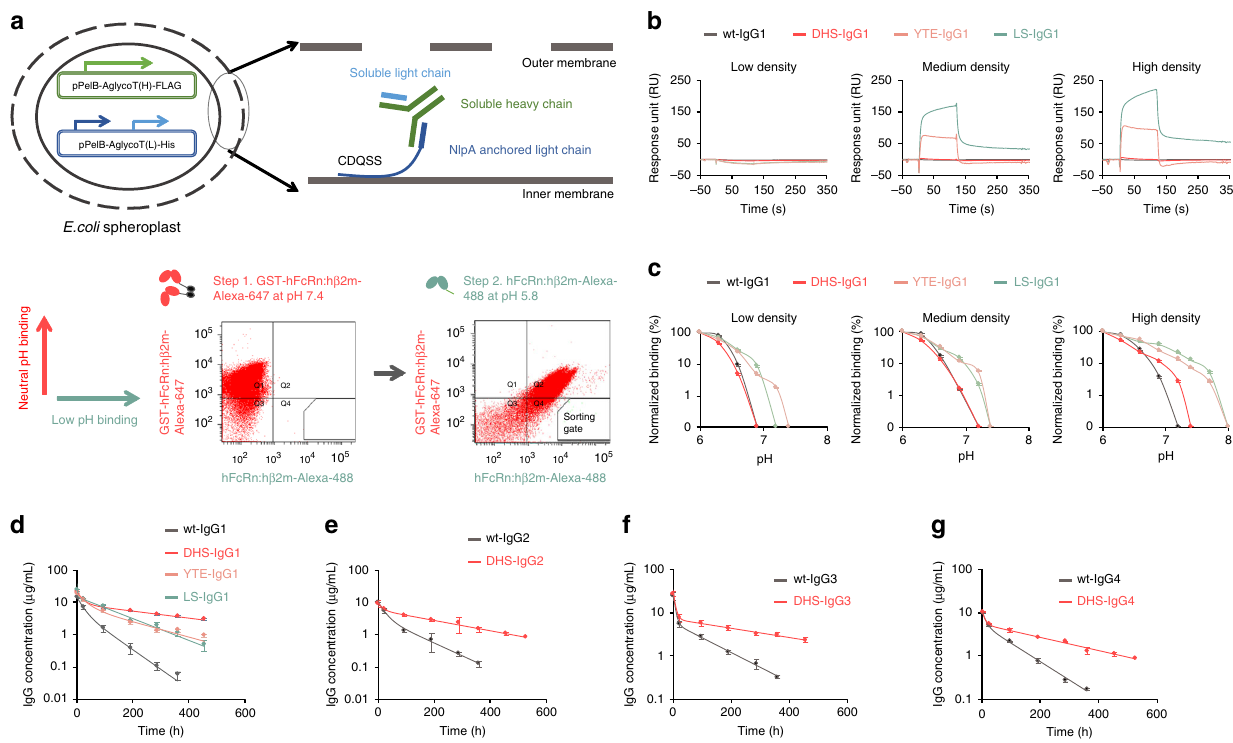
Fig. 1 Engineering a human Fc domain with optimized pH-dependent FcRn binding for ultra-long circulation persistence. a Screening strategy for the isolation of Fc mutations that confer favorable pH-dependent FcRn-binding using E. coli display. b , c SPR binding of IgG mutants (800 nM) to hFcRn:h β 2m immobilized at low, medium, or high density (500, 2000, and 4000 RU, respectively) either b at pH 7.4 or c as a function of pH. Normalized binding intensity was calculated as the pH-dependent RU over the RUmax at pH 6.0, for antibodies at 800 nM. Error bars: standard deviation from three independent experiments. d – g Serum antibody concentration of DHS formatted IgG1 ( d ), IgG2 ( e ), IgG3 ( f ), and IgG4 ( g ) antibodies in hemizygotic Tg276 hFcRn transgenic mice as a function of time after administration. Each antibody variant (2 mg/kg) was administered intravenously to hemizygous Tg276 mice ( n = 11 for IgG1 and n = 5 for IgG2, IgG3, and IgG4). Antibody concentrations were determined by ELISA.. Data are presented as mean ± standard deviation Table 1 K D values for binding of DHS, YTE, LS variants or